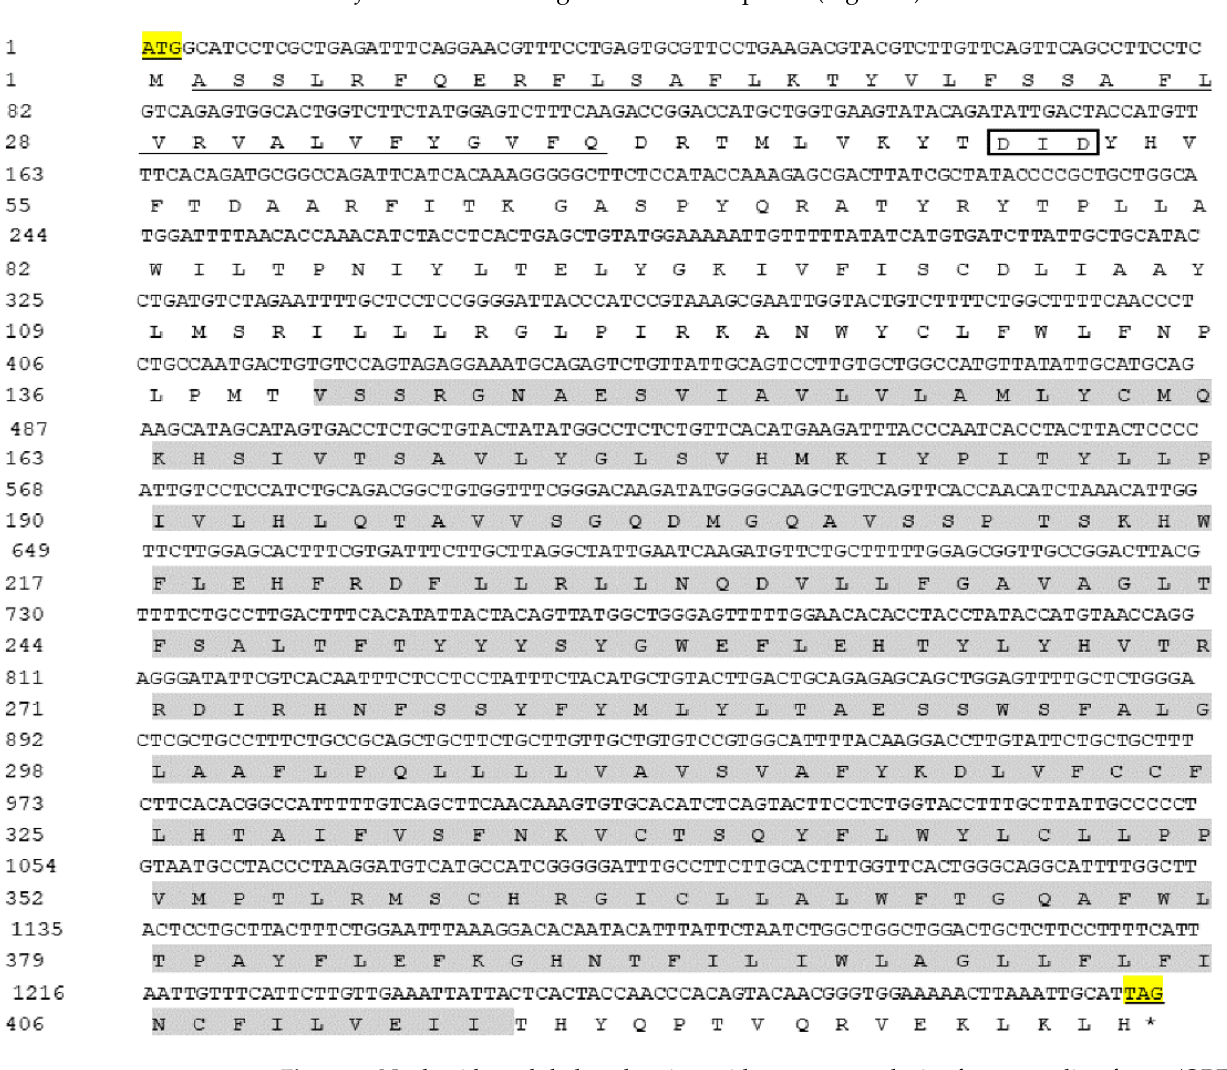
Figure 1. Nucleotide and deduced amino acid sequence analysis of open reading frame (ORF) of AdGPI-MT-I . Yellow highlights indicate start codons and stop codons, and asterisk indicates the termination of amino acids. The grey shading indicates the PMT2 super family domain, and the underlined part is the predicted signal peptides. The DXD motif is marked with a box ( □ ).